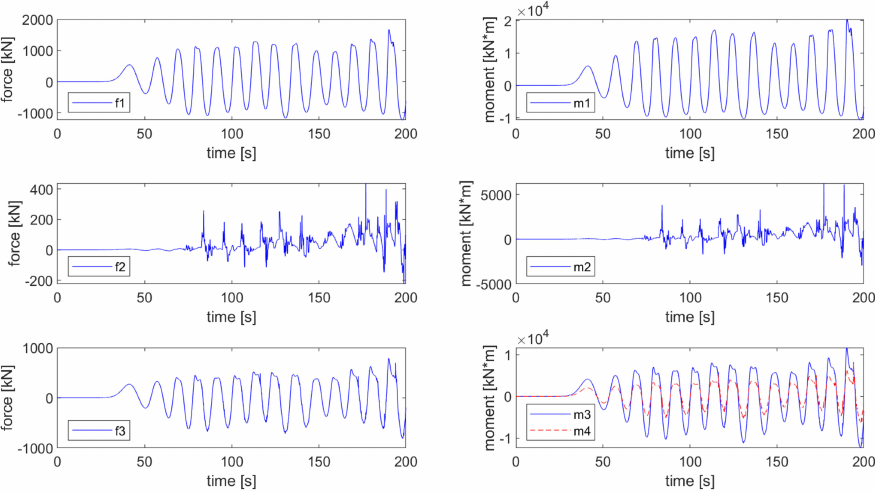
Figure 7. The time histories of wave-induced forces and their moment acting on caisson in case